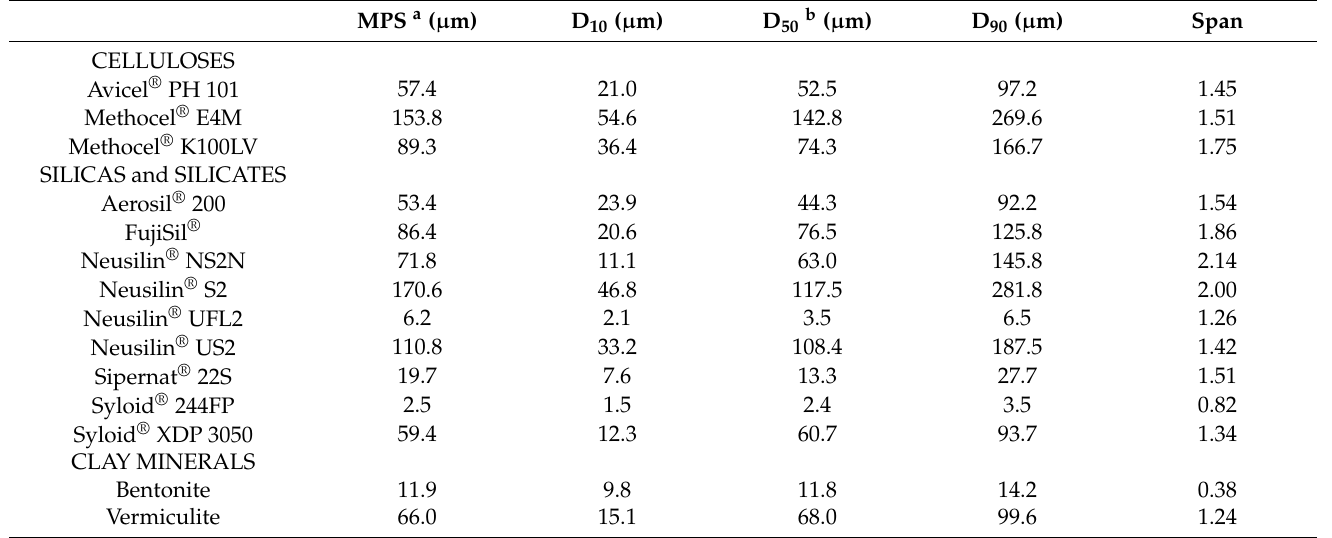
Table 1. Particle size of powder